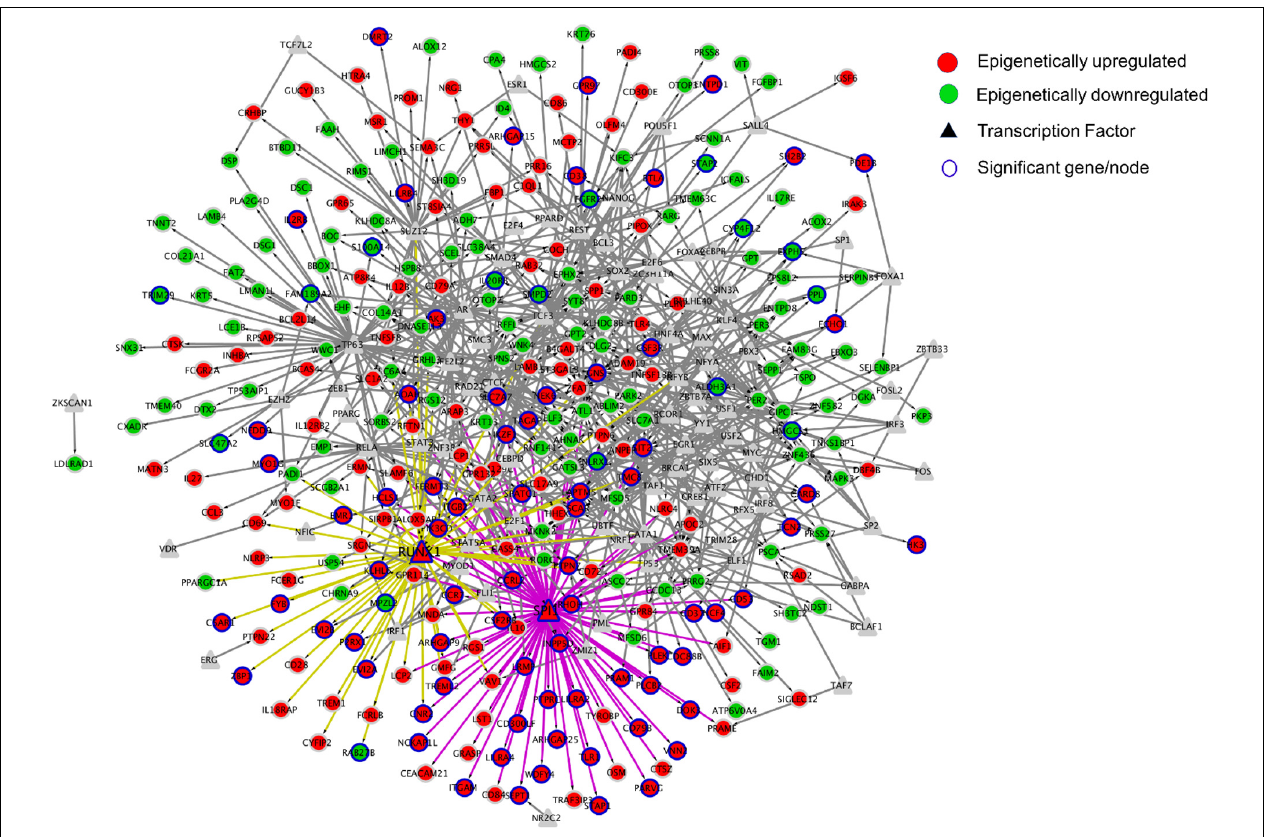
FIGURE 7 | Network visualization of Transcriptional Regulatory Network created using Cytoscape. In this study, Nodes represent the TFs and genes, whereas the edges represent the regulation between TFs and genes. Out of 435 differentially expressed and epigenetically regulated genes (241 upregulated and 194 silenced) identified in this study, transcription factors SPI1 and RUNX1 were predicted to be associated with 81 and 48 genes respectively. Fifty-three genes were predicted to be regulated by transcription factor TP63, which itself was not differentially expressed in tumor tissue in oropharyngeal